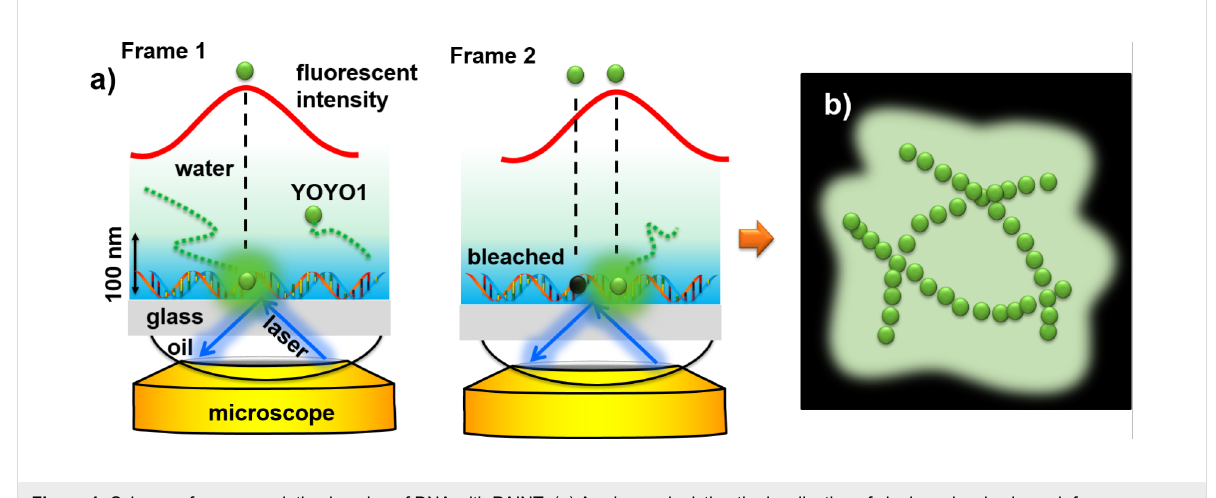
Figure 1: Scheme of super-resolution imaging of DNA with PAINT. (a) A scheme depicting the localization of single molecules in each frame. (b) Scheme of the reconstruction of a super-resolution image on top of a regular fluorescence image from the super-localized molecules in each